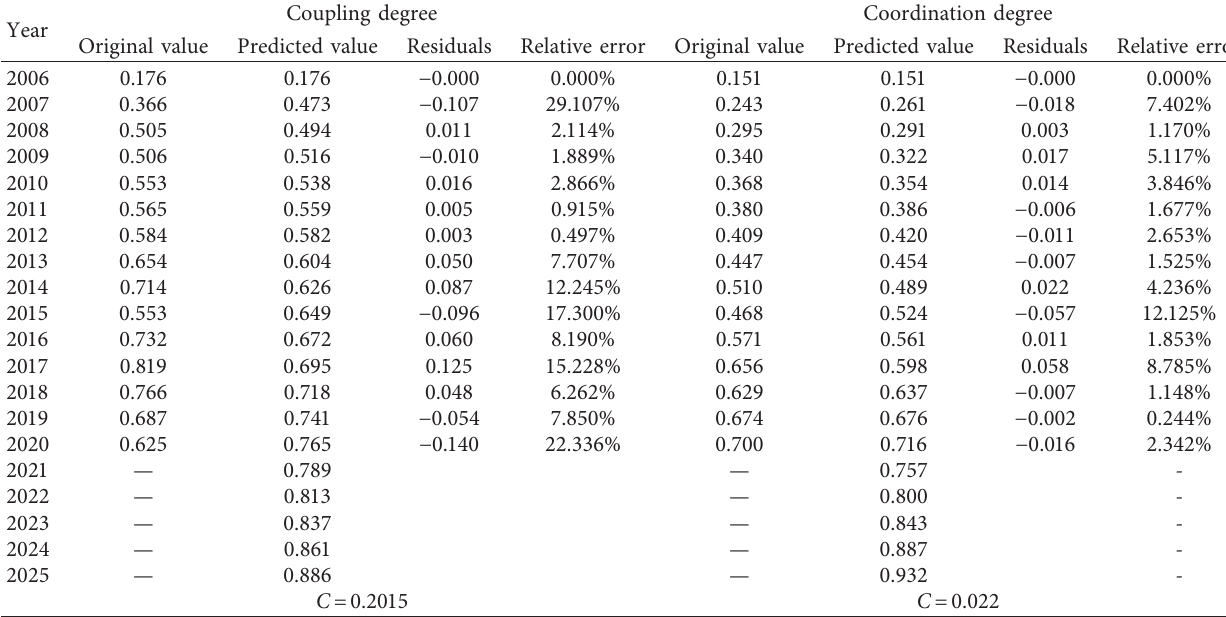
Figure 1: Coupling and coordination degrees over time. Table 5: Calculation results of coupling